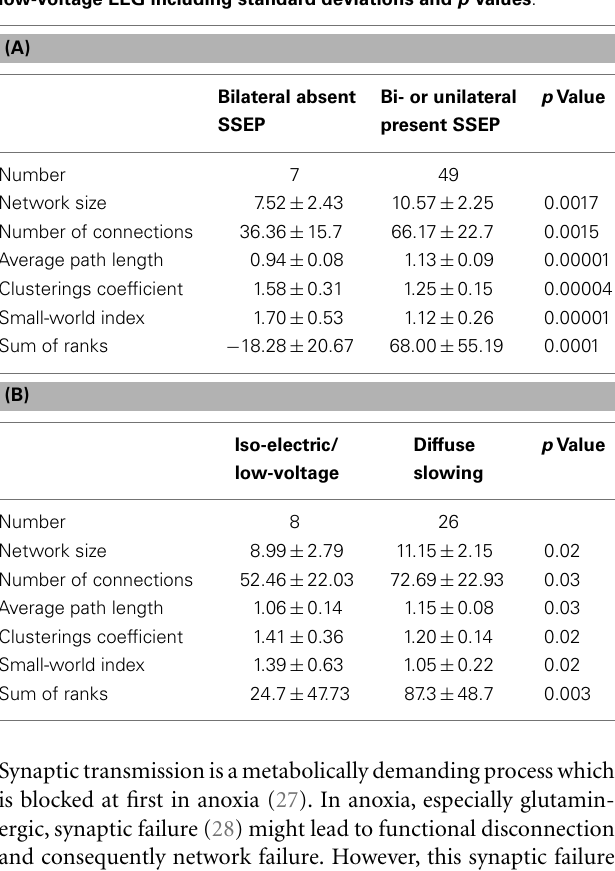
Table 2 | (A) Difference between network characteristics of patients with bilateral absent SSEP and uni- or bilateral present SSEP including standard deviations and p values and (B) difference between network characteristics of patients with iso-electric or low-voltage EEG including standard deviations and p values